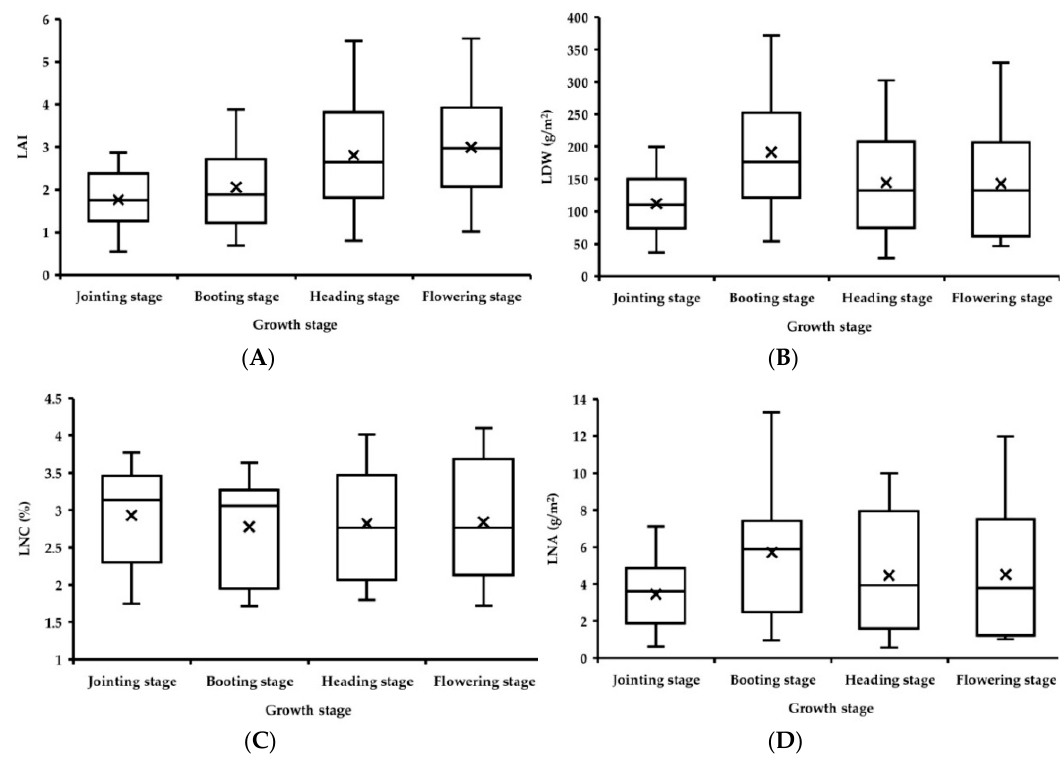
Figure 14. LAI ( A ), LDW ( B ), LNC ( C ) and LNA ( D ) of wheat at different growth stages.